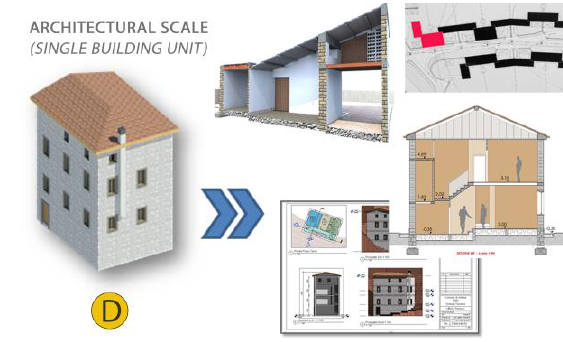
Figure 9. The Architectural scale (D): from the urban blocks to the single building unit. Development and implementation of the single parametric